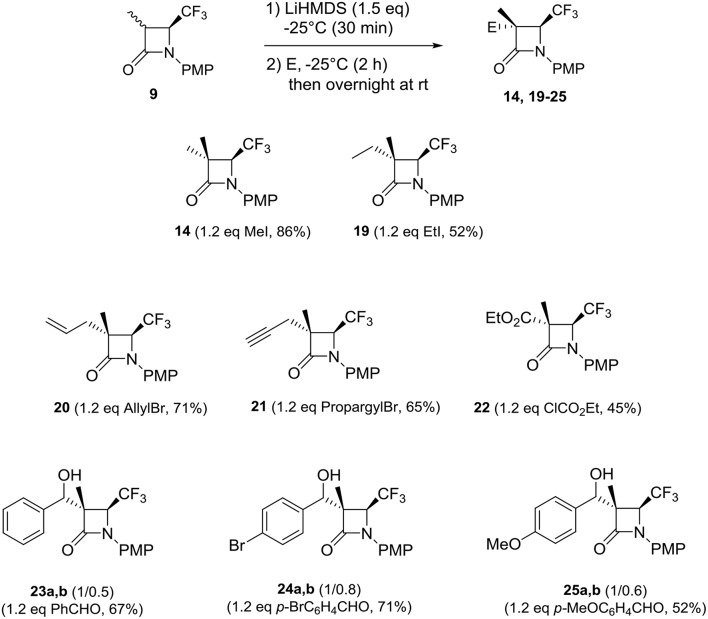
Reactions of 3-Me 4-CF3 β-lactams 9 with electrophiles.